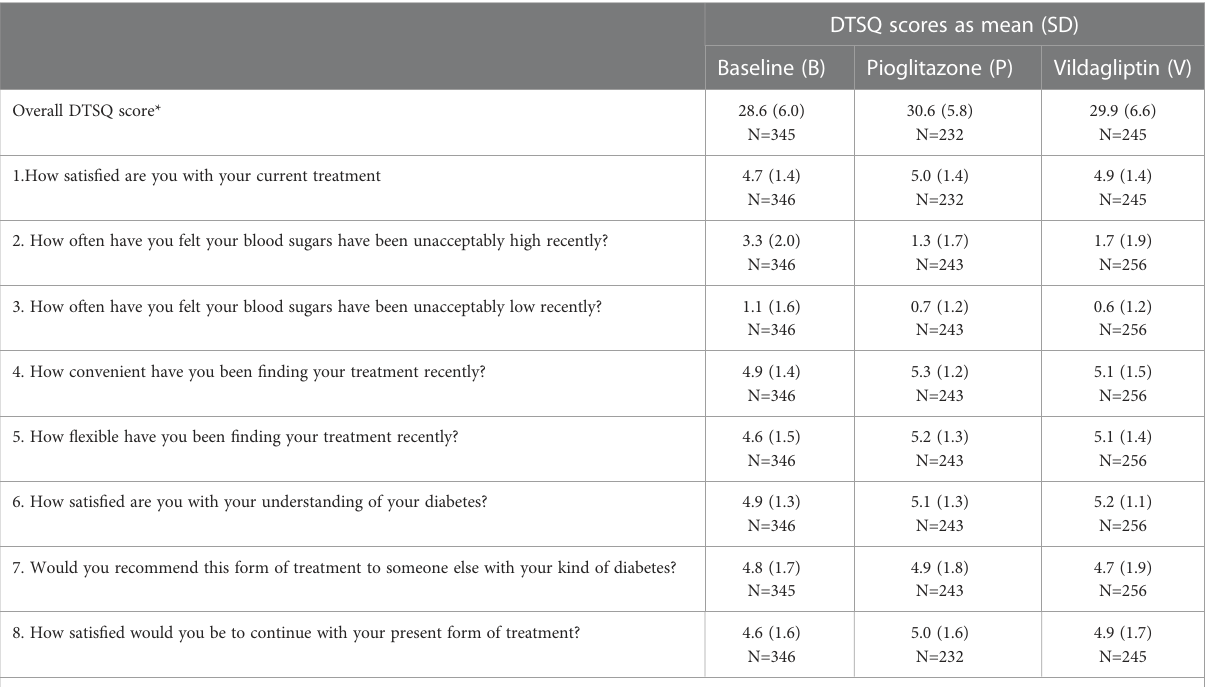
TABLE 5 DTSQ scores at baseline and after each